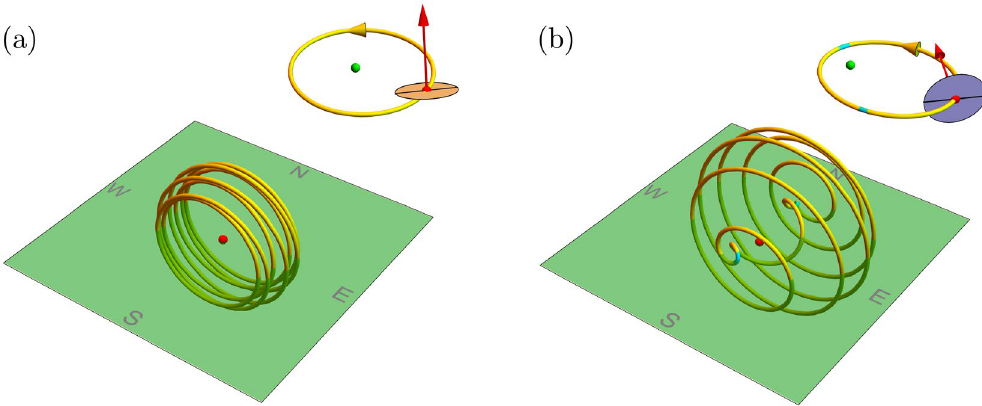
Figure 6. Ball plots. Dots (red) represent observers on their local horizons (green). ( a ) Earth-like planet with { ρ , e , ǫ , � } = { 8, 0.1, 0.4, 3.8 } , apparent solar motion (left) and orbit (right), with no reversals. ( b ) Exoplanet with { 8, 0.6, 1.5, 3.8 } , with apparent solar motion (left) and orbit (right), including reversals (cyan) not at